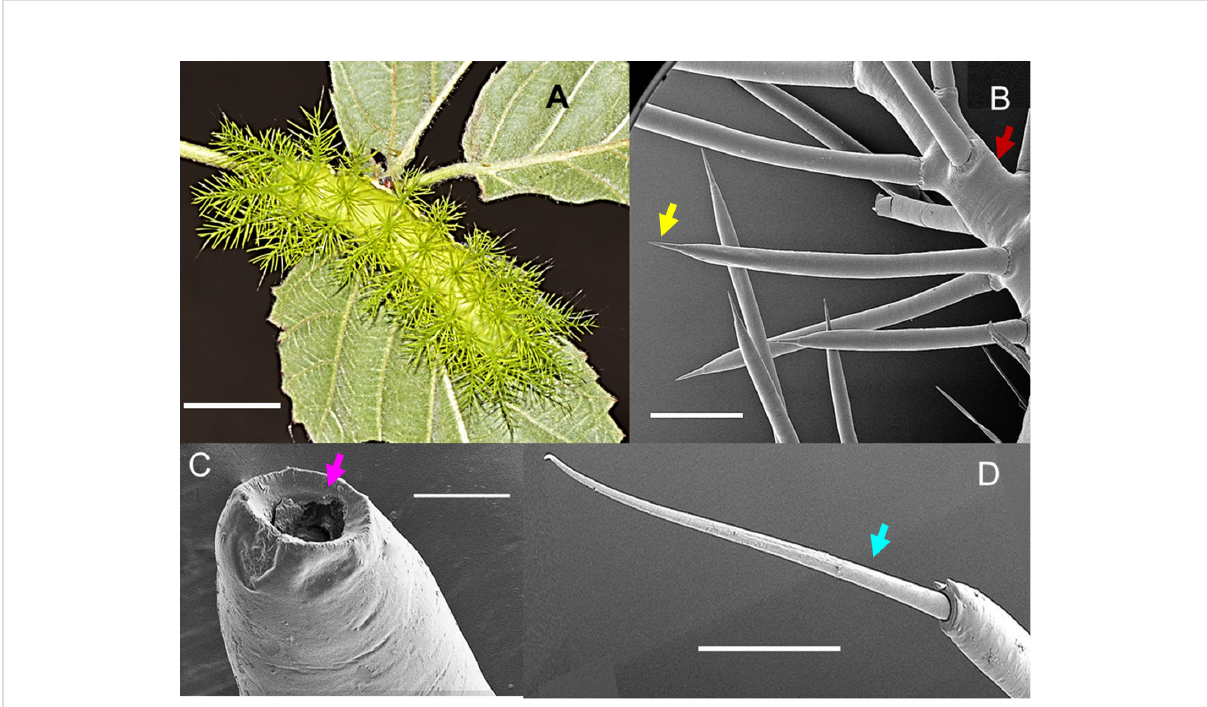
FIGURE 1 The caterpillar of the moth Automeris zaruma . (A) Mature larva covered with numerous dorsal and subdorsal spines (bar – 1 cm). Scanning electron microscopy of (B) stinging spines with a sharp-pointed tip (yellow) branching off a long skin tubercle (scolus, red) (bar – 600 µm). (C) The tip of the hollow spine (bar - 40 µm, pink). (D) setae-bearing spines (blue): smaller spines with a long and fl exible tip that originates from the scolus (bar- 200